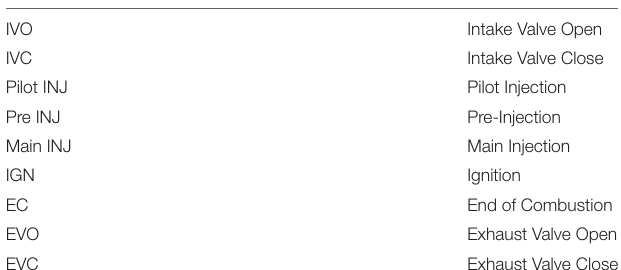
TABLE 2 | Discrete points of the DFE combustion control model.